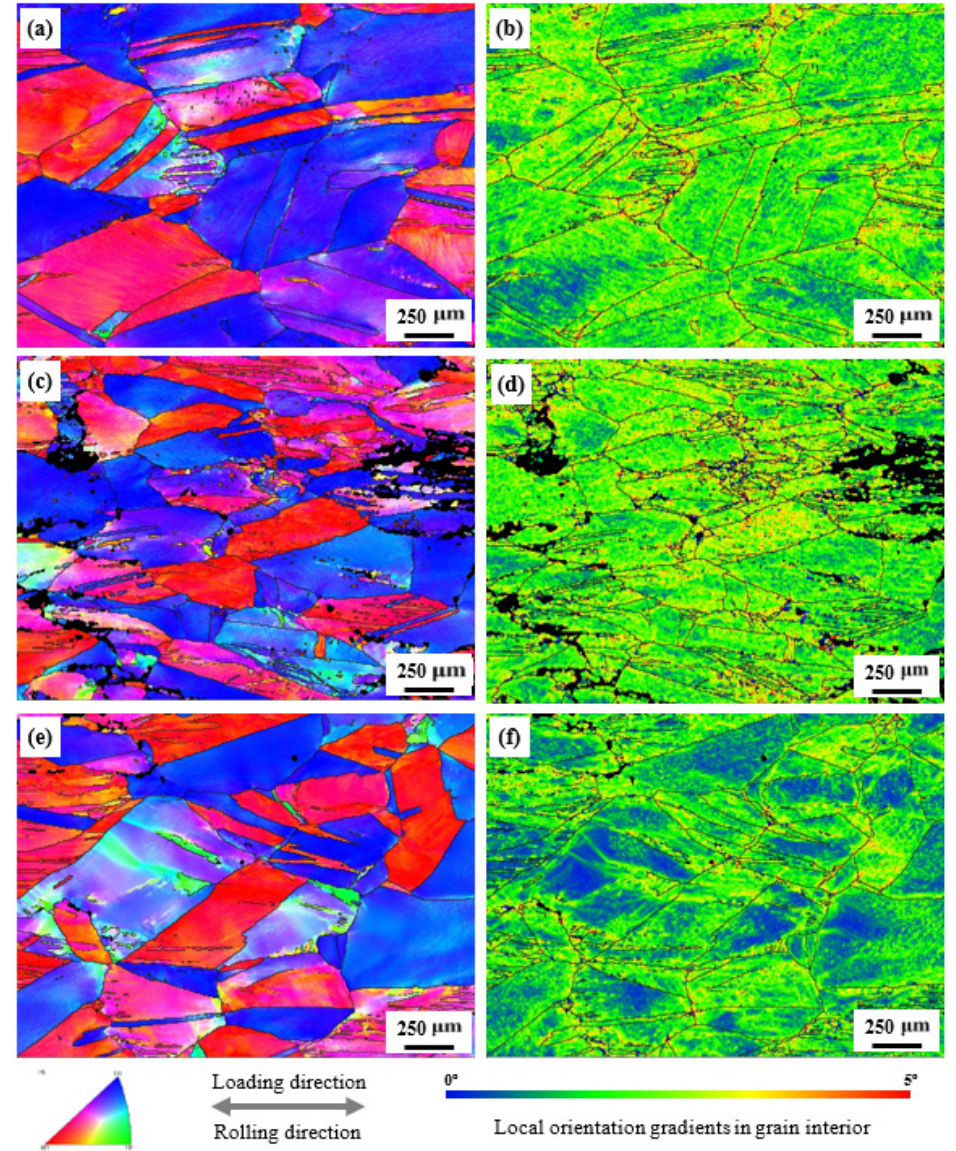
Figure 4. EBSD IPF and KAM maps of the steels subjected to a maximum uniform tensile deformation at ( a , b ) 298 K, ( c , d ) 77 K as well as ( e , f ) 4